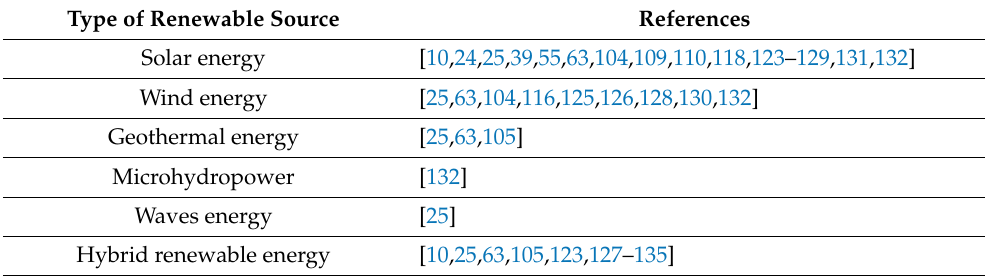
Figure 6. Renewable sources of energy for hydrogen production from seawater electrolysis. Table 8. Main renewable sources of energy that could be sustainably used for seawater electrolysis. Type of Renewable